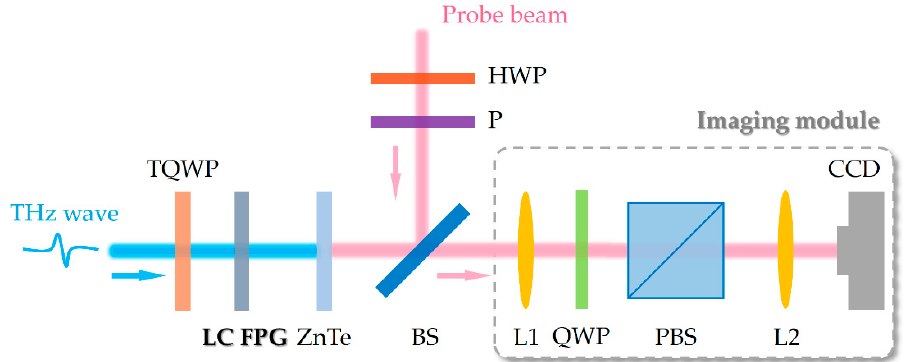
Figure 3. The scheme of the THz digital holographic imaging system.